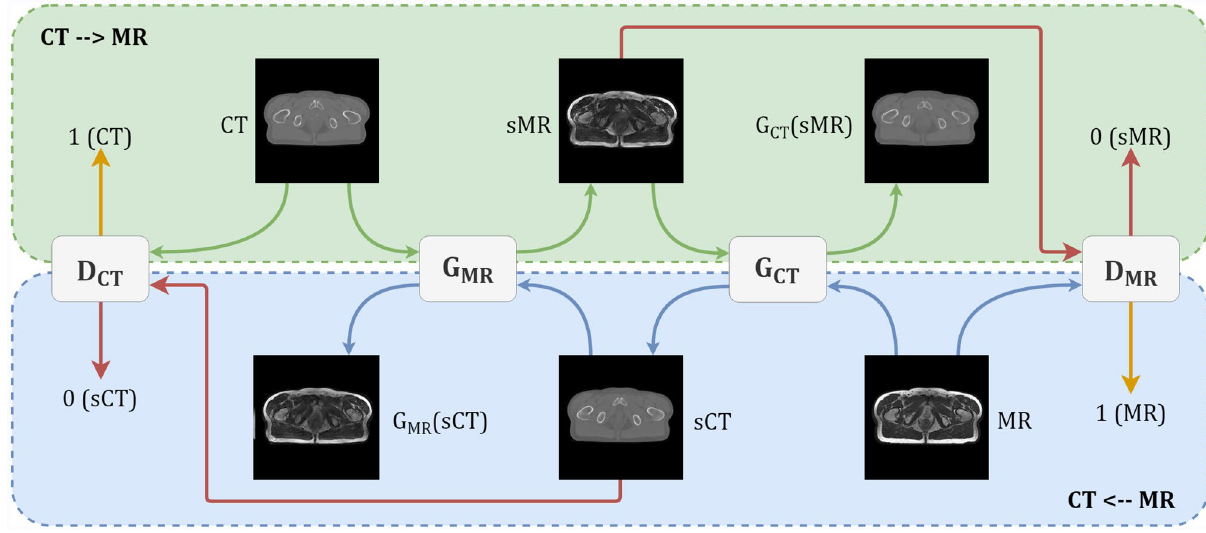
Figure 1. Overall pipeline for all the models. The green section shows CT to MR translation and recovery back to input CT using MR and CT generators, respectively. Similarly, the blue part corresponds to MR to synthetic CT conversion steps. If the input of the discriminator is a synthesized image, then ideally discriminator should output 0, i.e. fake image. This is denoted by the red colour